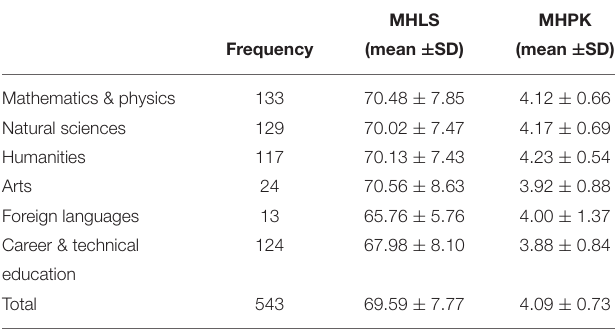
TABLE 2 | The frequency of undergraduate students in each study branch and their mental health literacy